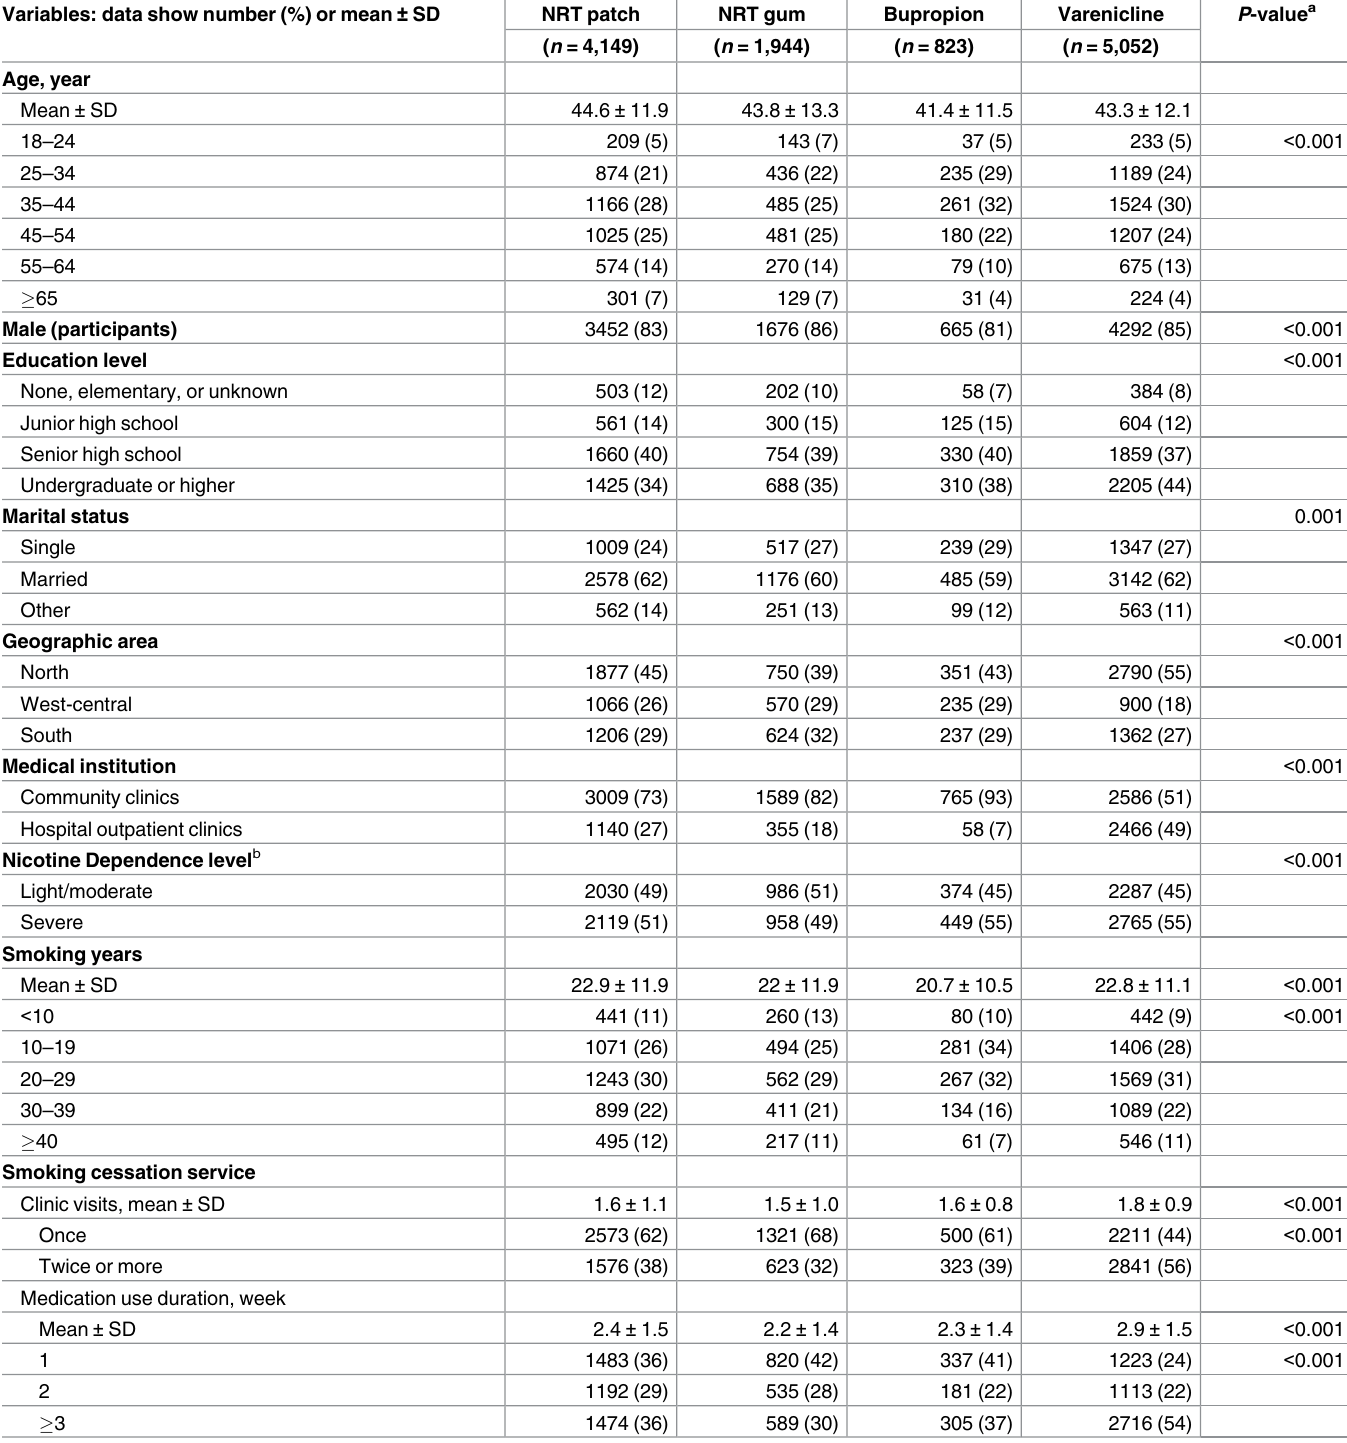
Table 1. Demographic characteristics of participants by medication